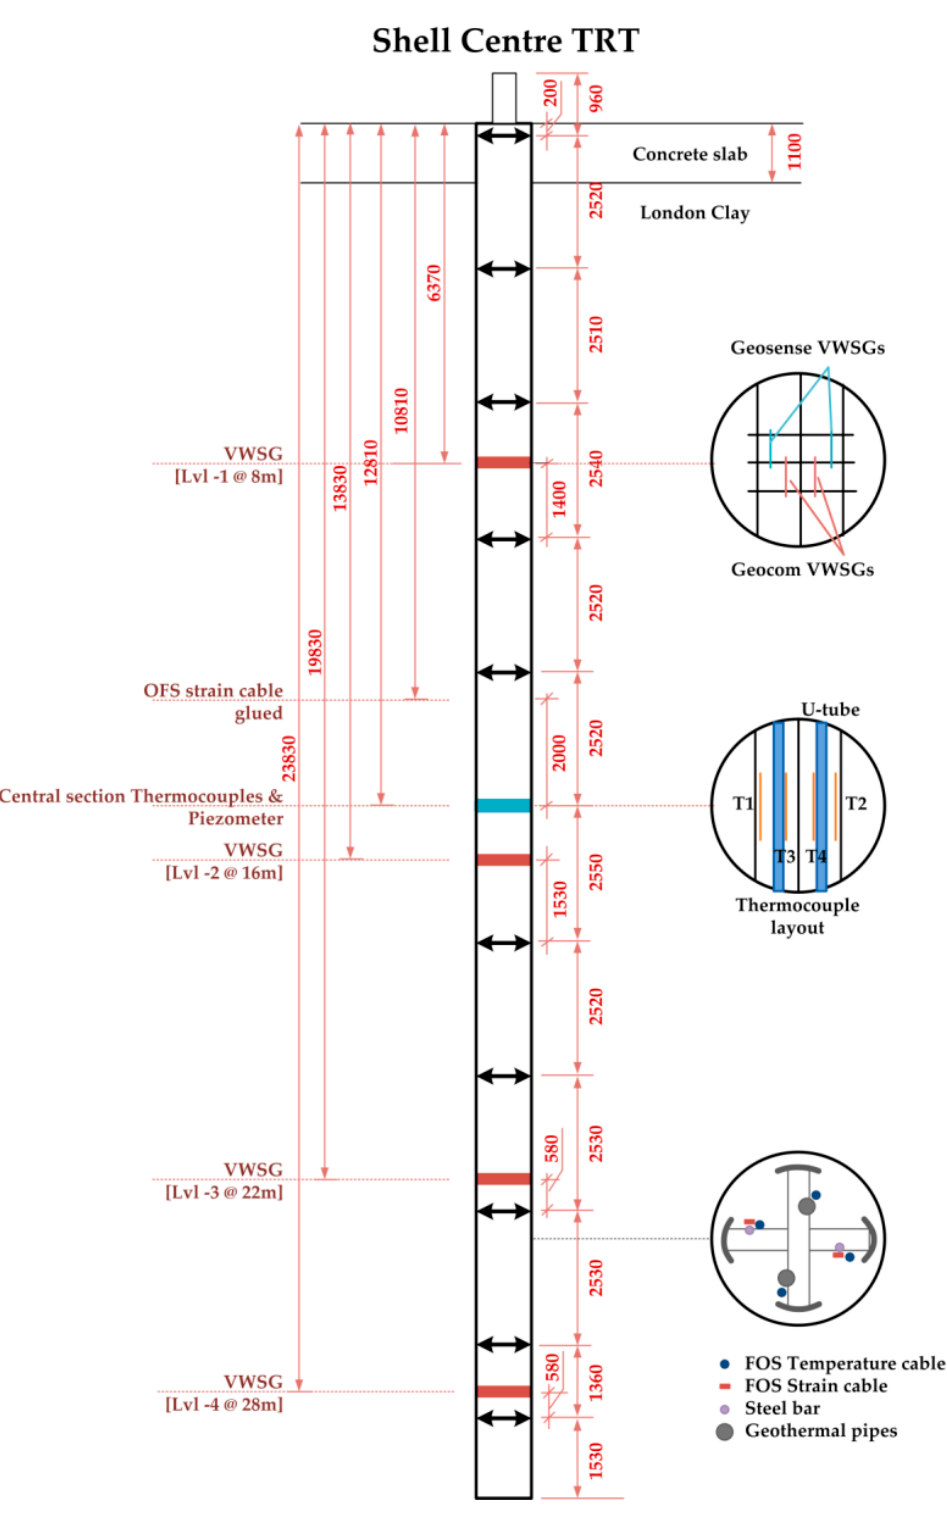
Figure 4. Built levels for the instrumentation in the borehole.